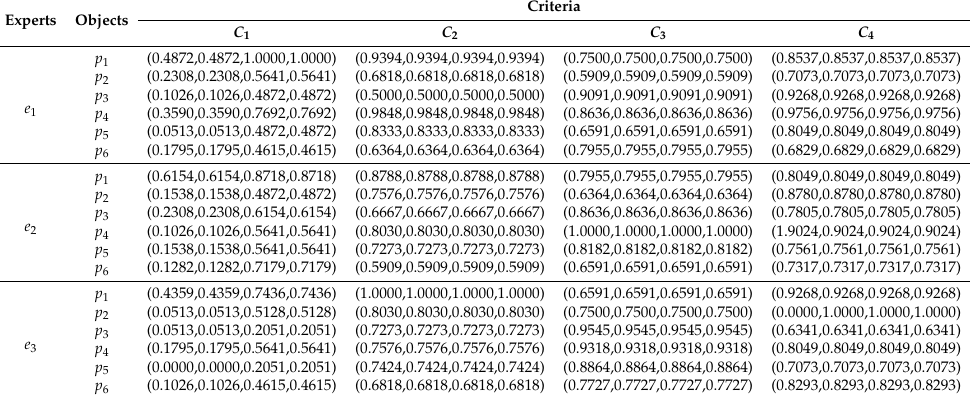
Table 6. Transformed information of ˜ X h .